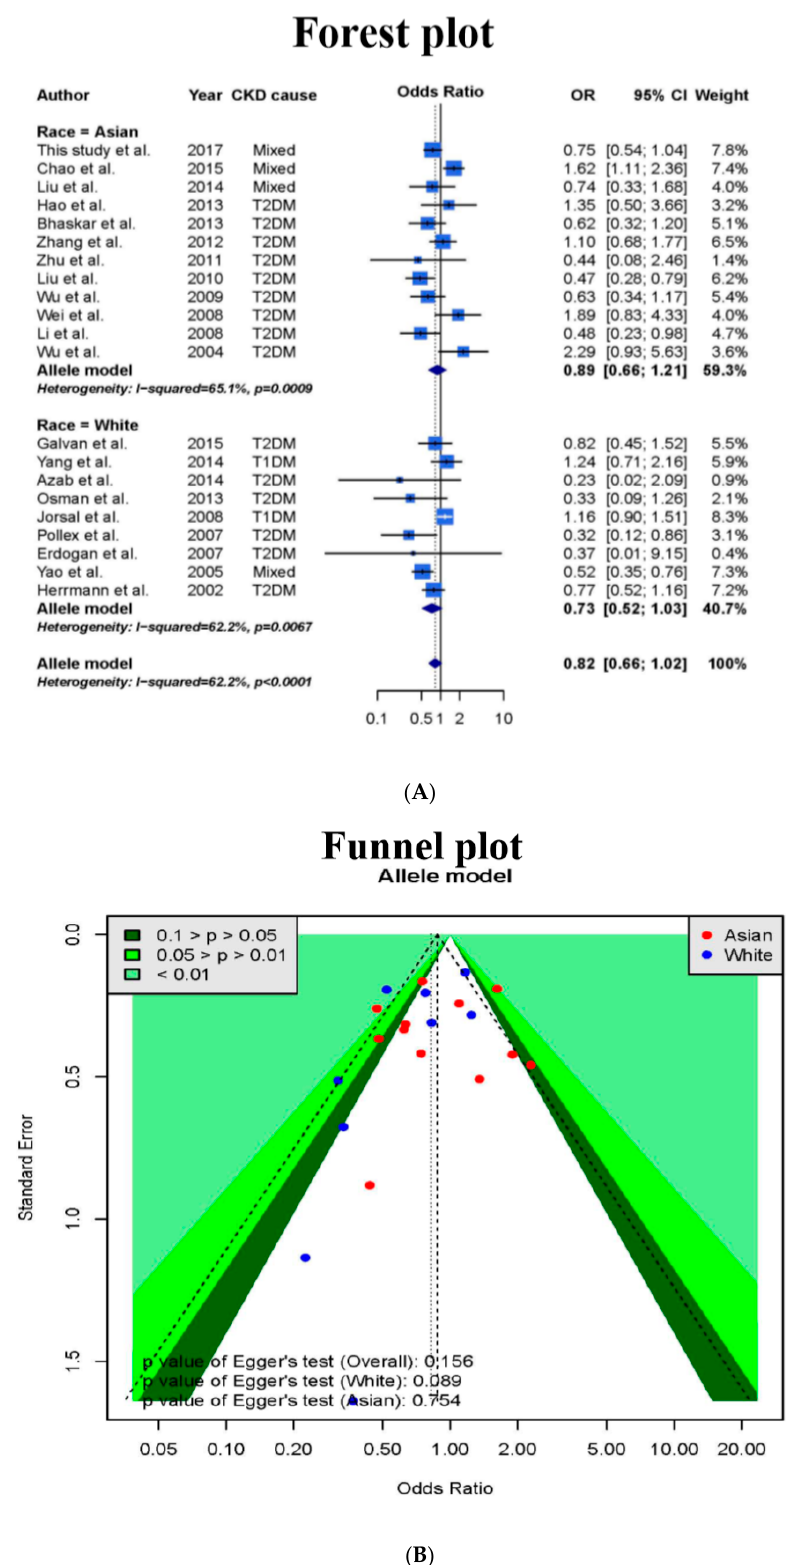
Figure 3. Forest plot and funnel plot showing the correlation between PPARG Pro12Ala alleles and CKD (including this study). ( A ) Forest plot of allele comparison for overall comparison. The list of article references are in Supplementary Table S5. ( B ) Funnel plot analysis showed no potential publication